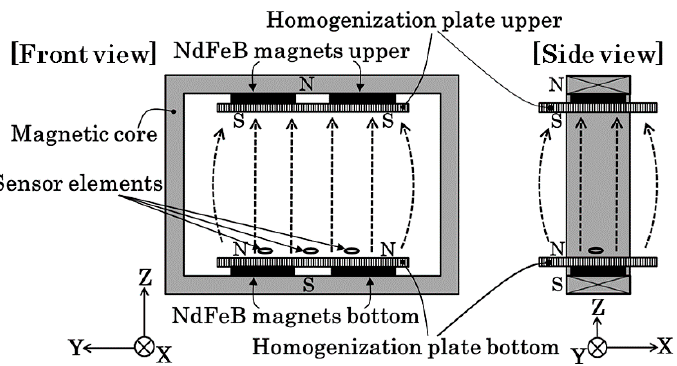
Figure 10. Schematic of the experimental apparatus (from [12]. The coordinates are revised to fit this paper.)